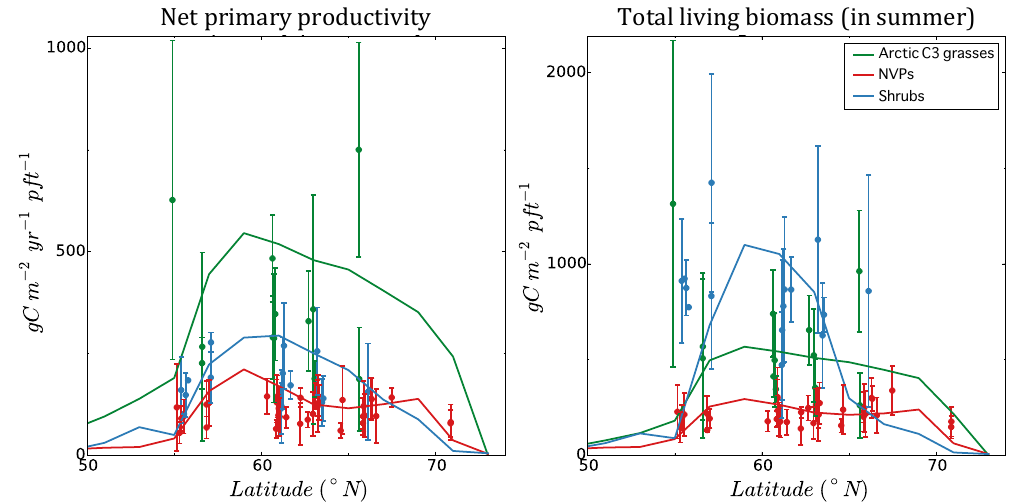
Figure 8. Latitudinal transects of the modelled and observed annual NPP and total living biomass in summer (July, August and September) over the period 2004–2013 for the new PFTs, namely boreal C 3 grasses (in green), non-vascular plants (in red) and shrubs (in blue). The simulated values are averaged over the longitudinal band 78–82 ◦ E, and per latitudinal band of 2 ◦ , from 50 to 74 ◦ N. The observations are aggregated by site (averaged for all years) for each new PFT.